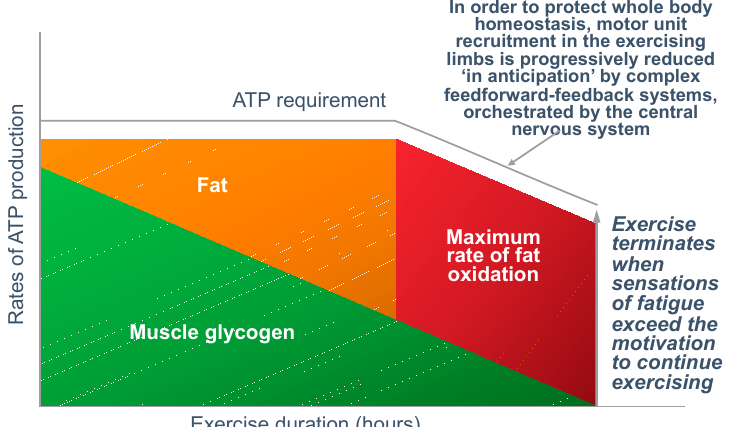
Figure 16. The extent of motor unit recruitment in the muscles in the exercising limbs determines the athlete’s exercise intensity. This also determines the metabolic response within those muscles. Thus, the most appropriate method to protect the muscles from a catastrophic metabolic outcome (Figure 12) is to regulate the number of motor units that are allowed to be activated in the muscles in the exercising limbs. This model therefore predicts that if the ability to generate ATP in the exercising limbs is restrained (‘limited’) for any reason, the immediate response of the central nervous system will be to reduce the number of motor units it chooses to recruit in those active muscles. This will ensure that homeostasis is maintained. Note this diagram suggests that exercise terminates only after muscle glycogen is completely depleted. In fact, the central governor ensures that exercise always terminates before this point is reached.